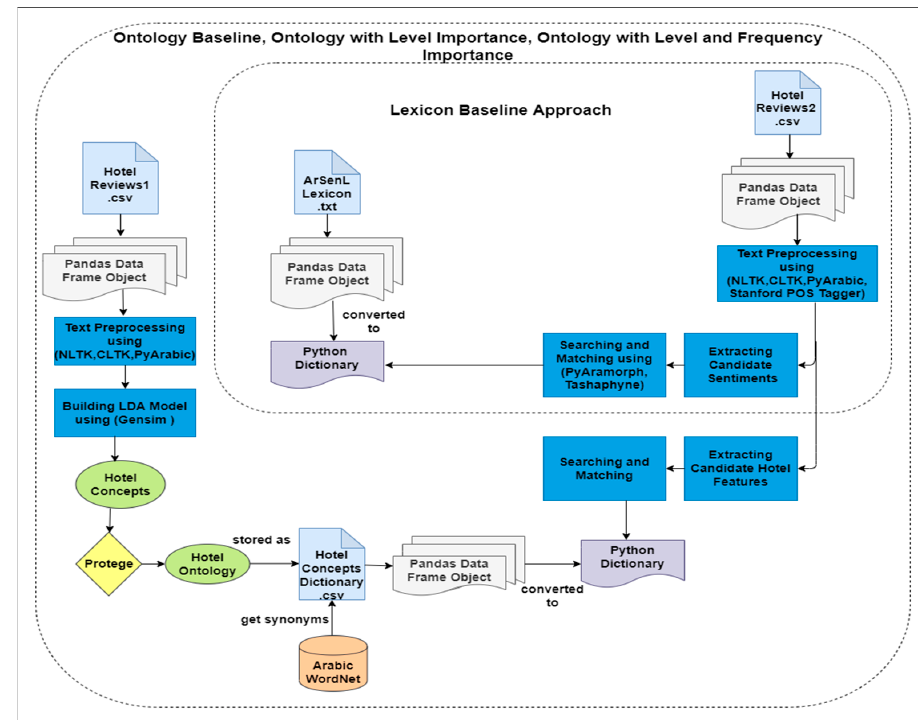
Figure 3. The tools and libraries that are used for semantic orientation evaluation.